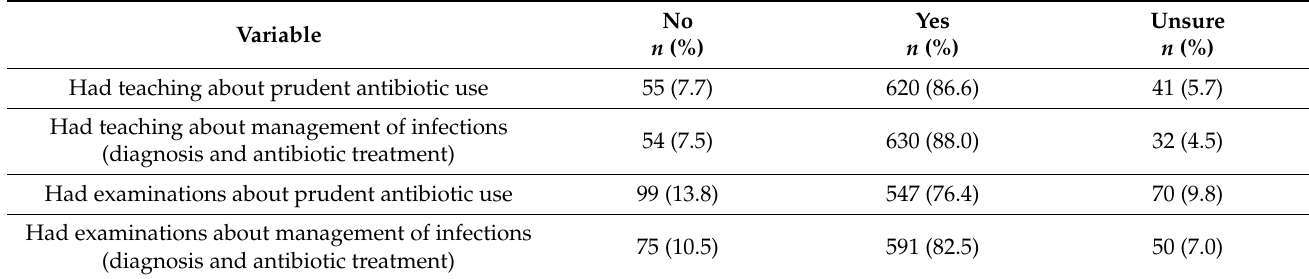
Table 7. Teaching received by the students regarding antibiotic